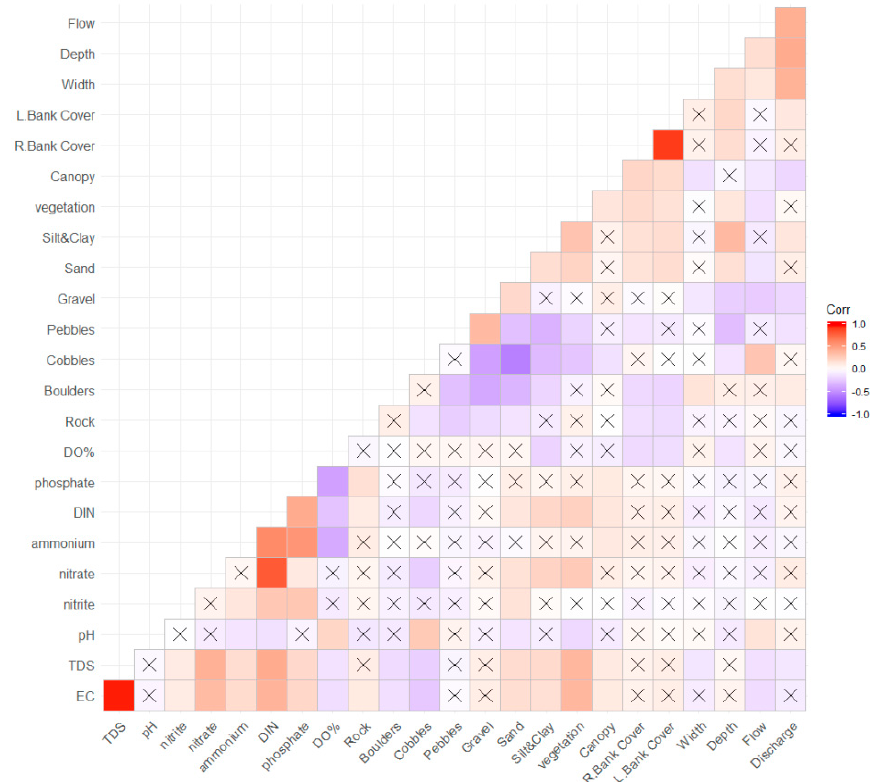
Figure 2. Correlogram showing the correlations between environmental variables. Positive correlations are displayed in red and negative correlations in blue color. Color intensity is proportional to the correlation coefficient. The X mark means insignificant correlations.